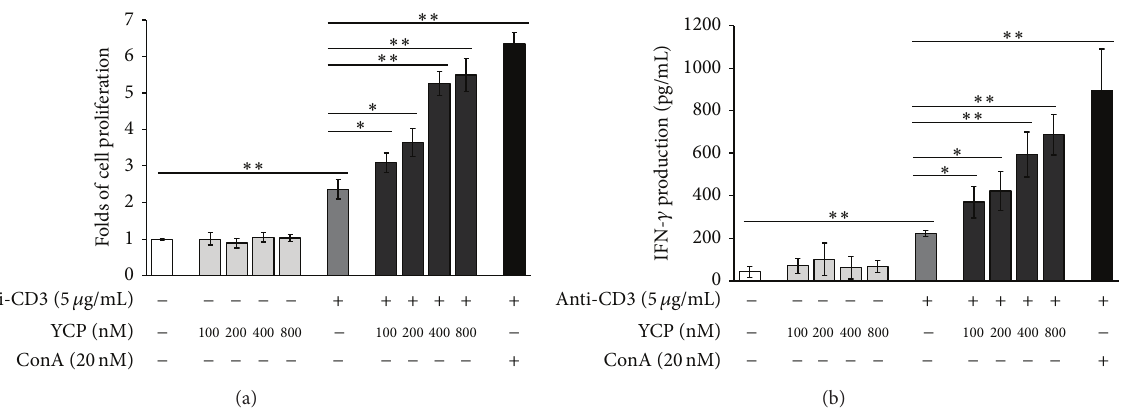
Figure 1: The effects of YCP on T cell proliferation and IFN- 𝛾 production as the second signal in TCR activation. (a) Effect of YCP on T cell proliferation. Splenic T cells prestimulated with aCD3 or PBS were treated with YCP or ConA at the indicated concentrations, and cell proliferation was measured by MTT assay at 48 h ( 𝑛 = 6 , ∗ 𝑃 ≤ 0.05 , ∗∗ 𝑃 ≤ 0.01 by Kruskal-Wallis test followed by Dunn’s post hoc test). (b) Effect of YCP on T cell IFN- 𝛾 production. Splenic T cells prestimulated with aCD3 or PBS were treated with YCP or ConA at the indicated concentrations, and IFN- 𝛾 production was measured by ELISA assay at 48 h ( 𝑛 = 6 , ∗ 𝑃 ≤ 0.05 , ∗∗ 𝑃 ≤ 0.01 by Kruskal-Wallis test followed by Dunn’s post hoc